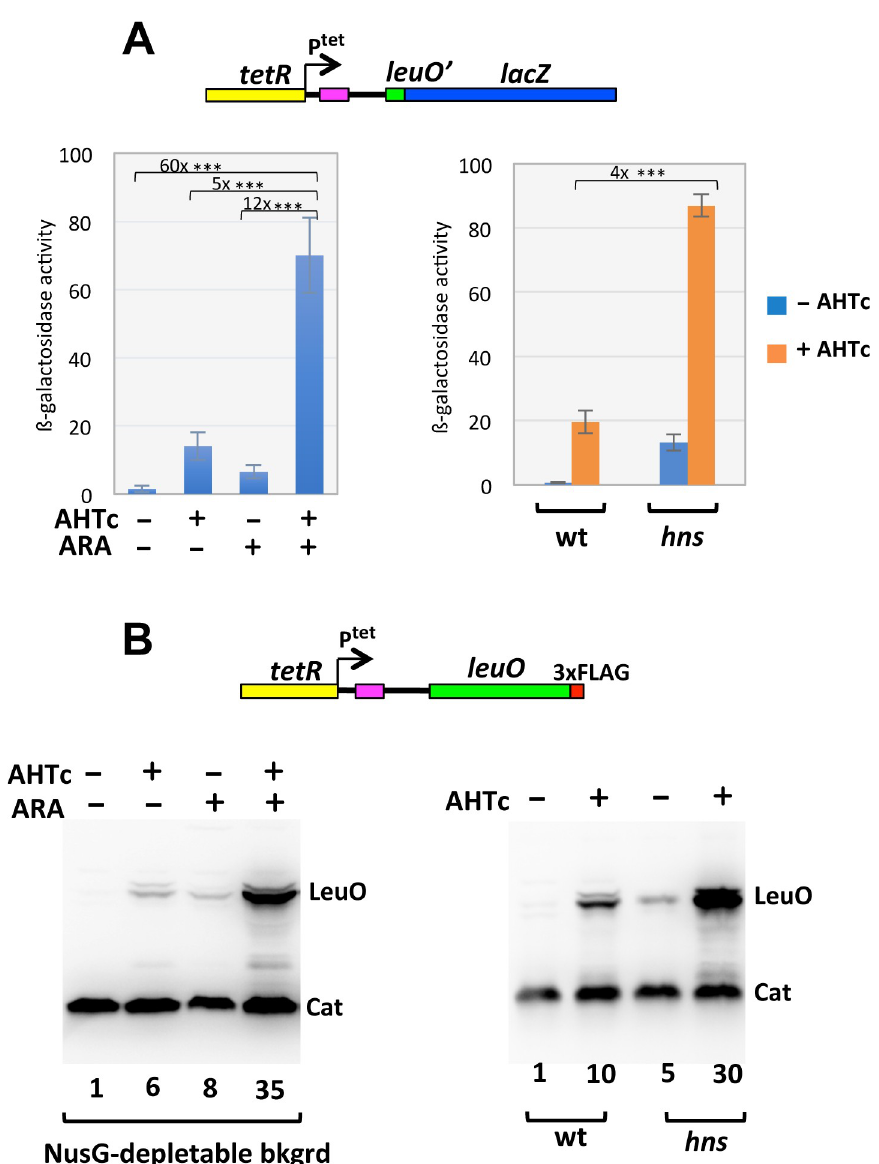
Fig 4. Relief of leuO repression by invading transcription. A DNA segment encompassing the tetR repressor gene and the tetA promoter (P tet ) is placed upstream of the H-NS-binding site (purple shading), itself upstream of the leuO gene, in two separate contexts: a leuO-lacZ fusion (A) and a 3xFLAG-tagged version of leuO (B). The effects of transcription from P tet ( ± AHTc) are analyzed in the presence or absence of NusG (- ARA and + ARA, respectively) ( left ) or in the presence of hns mutation hns -123fs ( right ). (A) Quantification of leuO-lacZ expression. Early stationary cultures were processed for the determination of ß-galactosidase activity as described in Materials and methods. The assays were repeated twice, each time using two independent cultures. Statistical significance was calculated by the Student’s T test (two-tailed, unpaired; ��� , P < 0.001). (B) Western blot detection and quantification of LeuO-3xFLAG. Values below the blots represent the fold change in band intensity (quantified with ImageJ), relative to the untreated sample (leftmost lane), normalized to the Cat band for each lane.